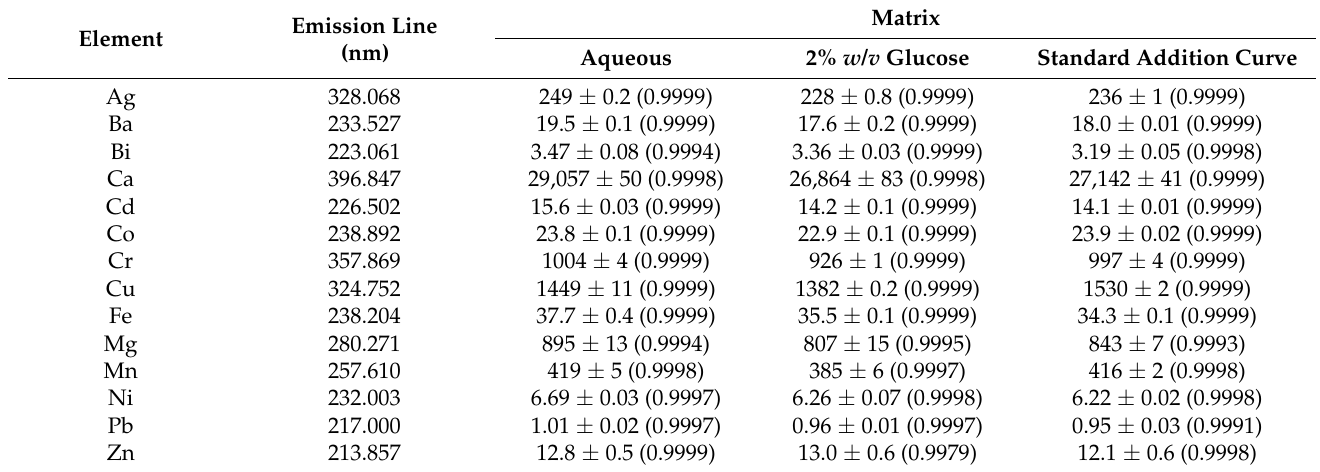
Table 3. Slope ± standard deviation (coefficients of determination) of the different